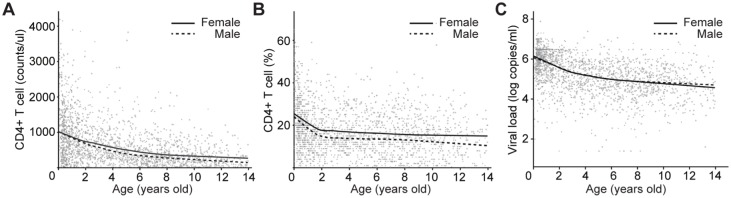
Sex differences in CD4+ T cell count, CD4% and viral load, amongst 2,101 ART-naïve South African children.A. Absolute CD4 counts changes with age. B. CD4% changes with age. C. Viral load changes with age. In each panel, the solid lines are Loess-smoothed regression lines for female children and the dotted lines are Loess-smoothed regression lines for male children. A multivariable linear regression model, with both sex and age as covariates, shows significantly lower absolute CD4 counts in males (p = 0.005); significantly lower CD4% in males (p = 3.7x10-7); and no significant difference in viral load between the sexes.